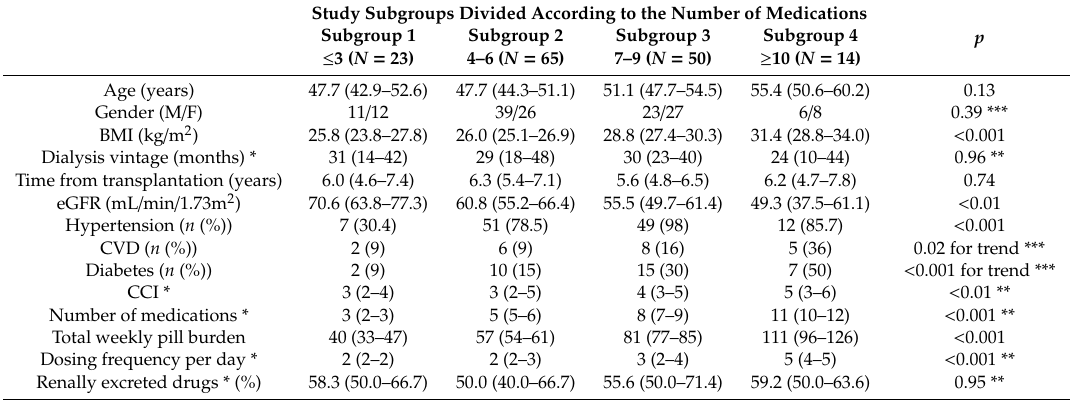
Table 1. The clinical characteristics of patients divided into the study subgroups according to the number of regularly prescribed medications.